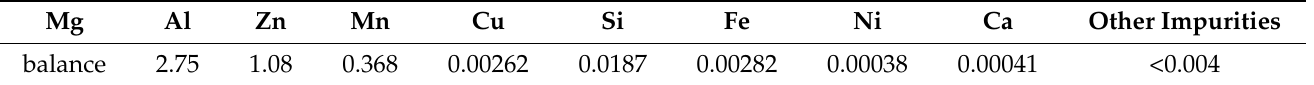
Table 1. Chemical composition of the AZ31B sheet metal in weight percent (wt%) [26]. Mg Al Zn balance